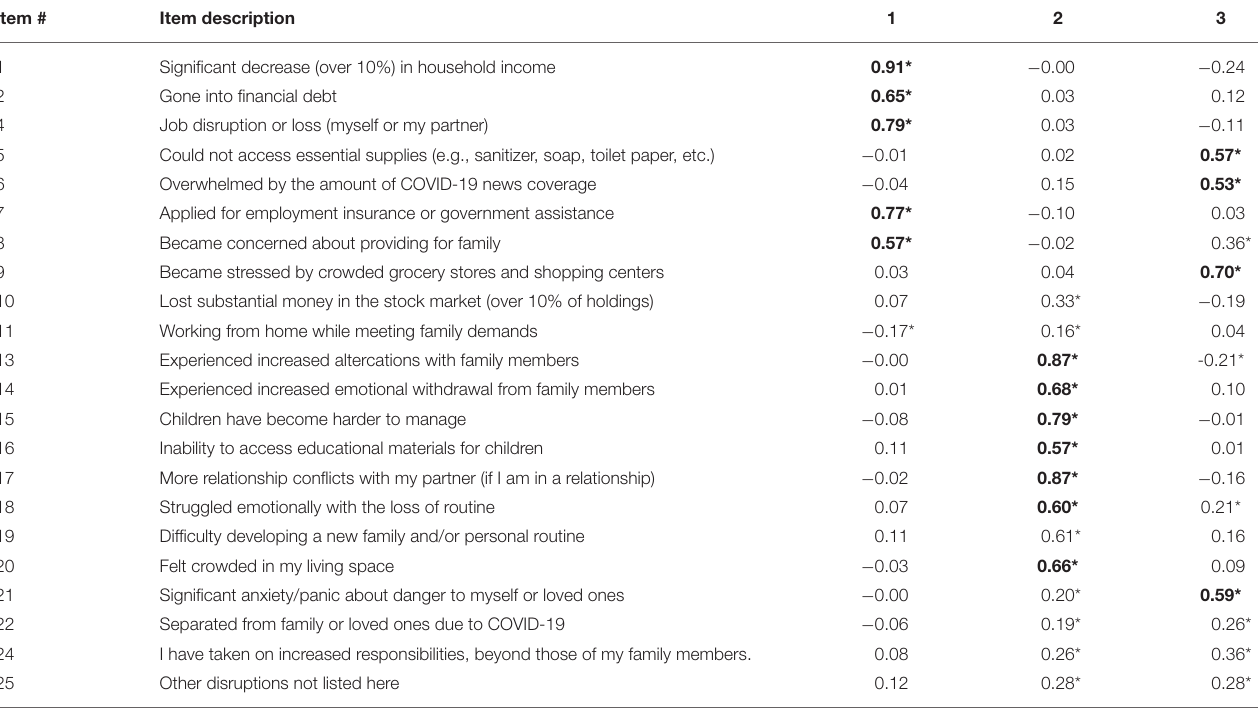
TABLE 2 | Exploratory factor analysis three-factor solution (geomin rotated loadings).